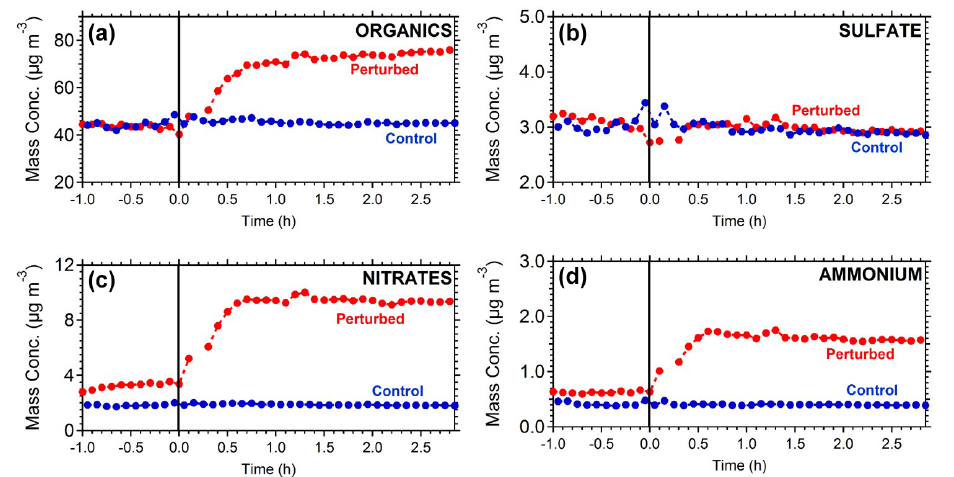
Figure 1. Particle wall-loss-corrected aerosol mass concentration (CE = 0 . 4) for the AMS-measured (a) organics, (b) sulfate, (c) nitrates, and (d) ammonium in both the perturbed (red line) and the control chamber (blue line) during Exp.